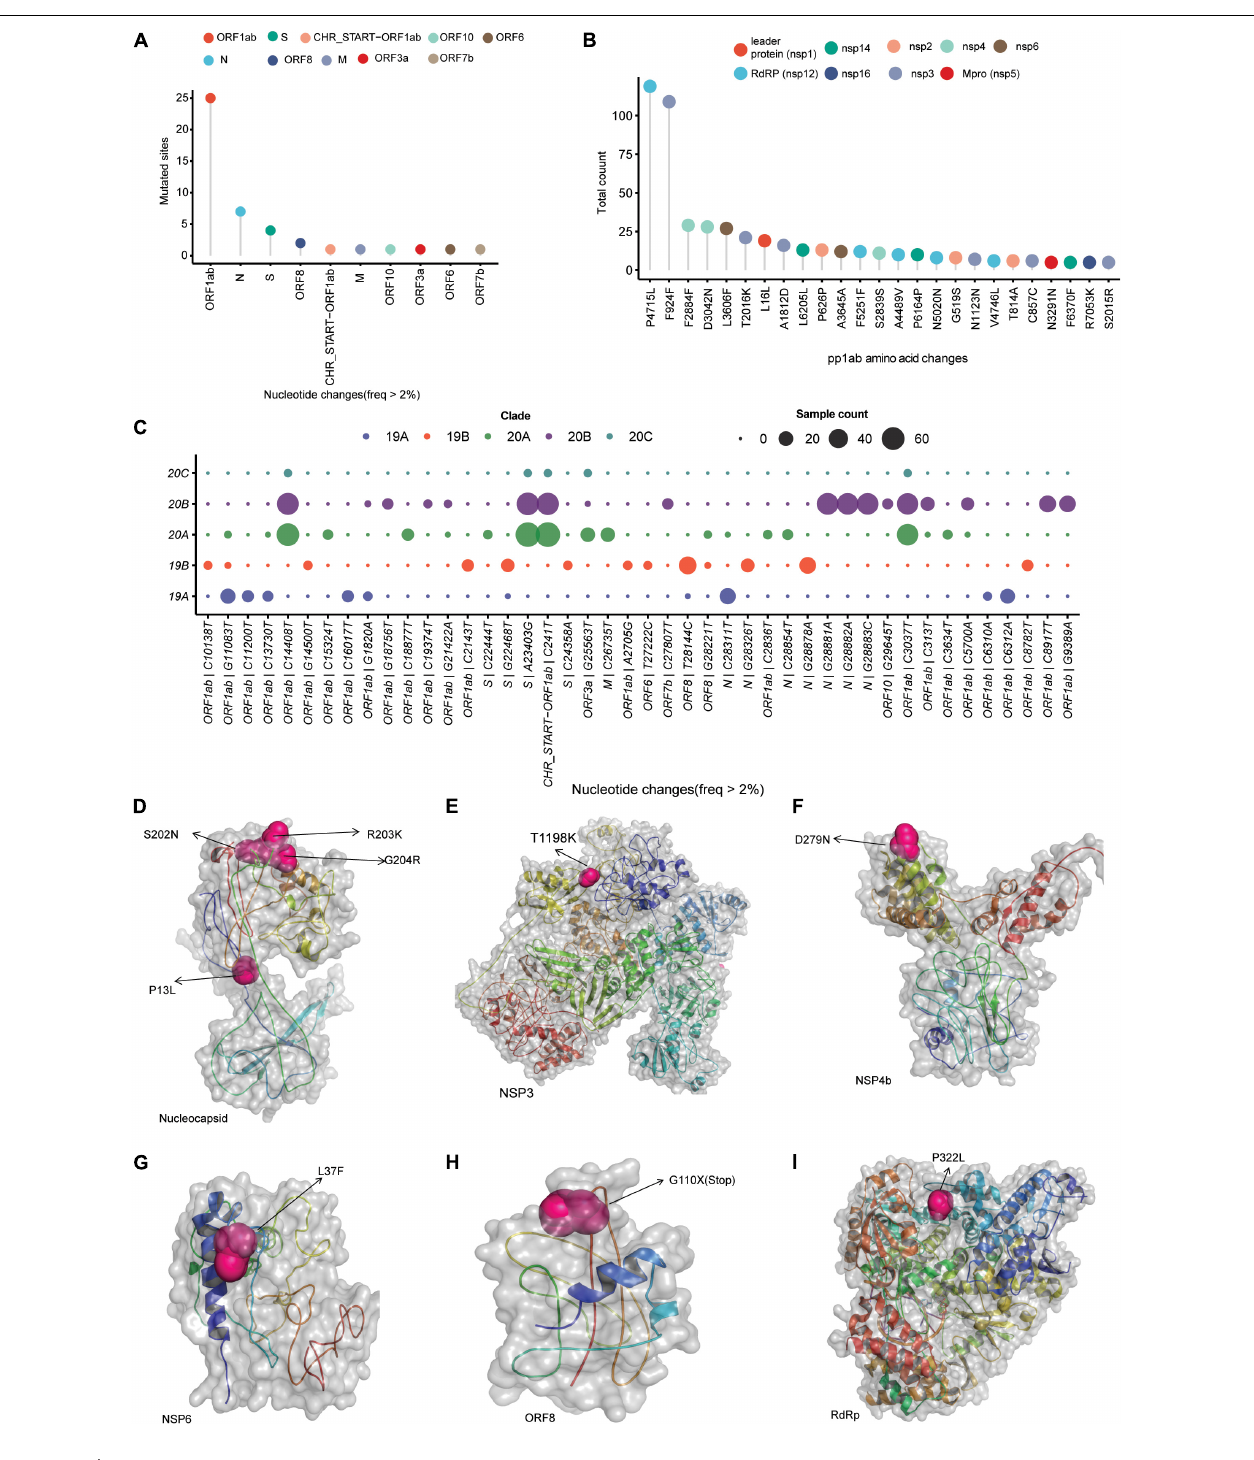
FIGURE 2 | SARS-CoV-2 clade distribution and their prevalent mutation profiles. (A) Dot plot representing the number of single-nucleotide mutation (occurred in more than 2% of the samples) present in different genomic segments of SARS-CoV-2 genome. (B) The ORF1ab region codes for a polypeptide are later cleaved to several mature peptides. The dot plot represents the amino acid changes (location of amino acid acids as per location in polypeptide sequence) in the mature peptides of ORF1ab. (C) Clade-wise occurrence of nucleotide mutations with presence in more than 2% of sequenced samples ( n = 202). Color of the dots represents the clade and size of the dots represents number of the samples showing presence of the single-nucleotide variant. (D–I) The mutation sites on the modeled structures of the SARS-CoV-2 proteins. The mutation site(s) of the NSP3, NSP4b, NSP6, RdRP, and nucleocapsid proteins are marked as sphere, while the rest of the structure is shown in cartoon